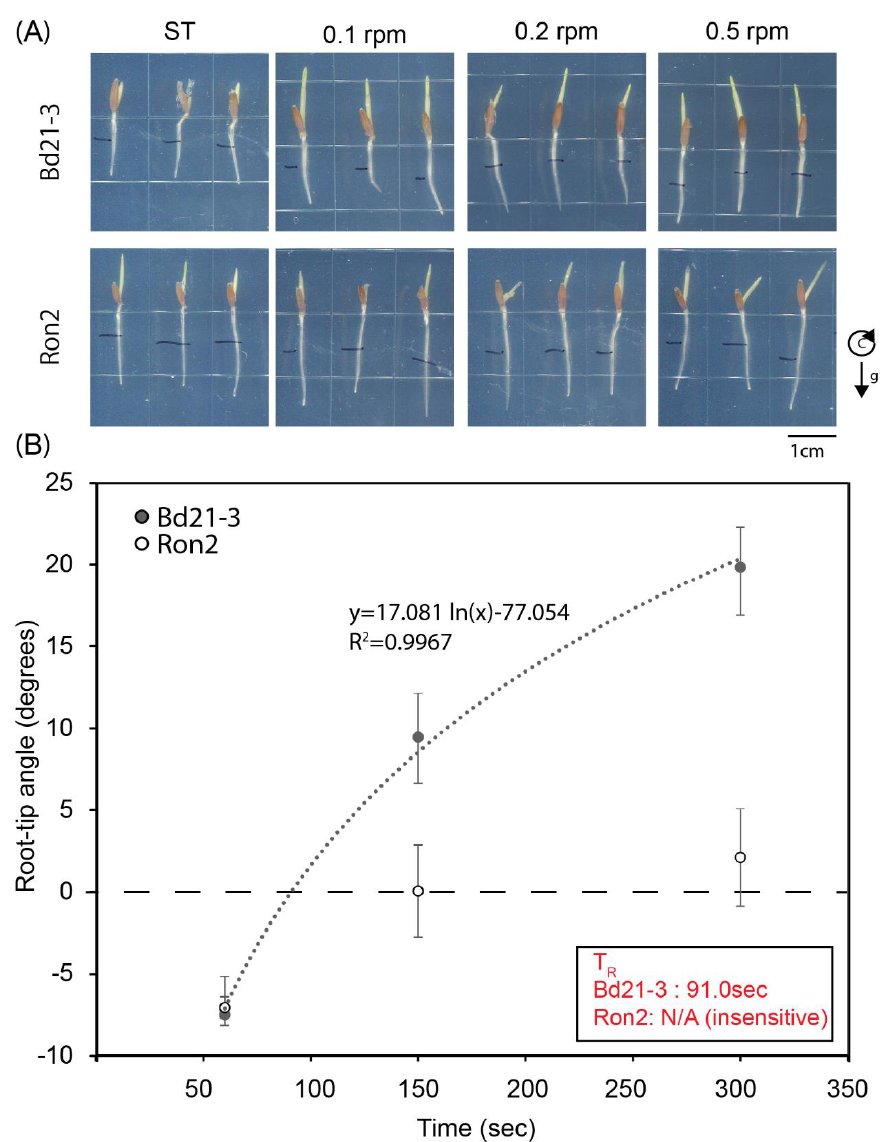
Figure 6. Brachypodium distachyon accessions display distinct root tip curvature responses to low- speed clinorotation: 3-day-old Brachypodium distachyon seedlings of the Bd21-3 and Ron-2 accessions were subjected to clinorotation at speeds of 0 (ST control), 0.1, 0.2, and 0.5 RPM for 14 h in darkness. The seedlings were photographed at the end of each experiment. Panel ( A ) shows representative root tip images of Bd21-3 and Ron-2 seedlings exposed to the clinorotation conditions summarized at the top. ( B ) Averaged root tip angles at the end of clinorotation along with their standard devia- tions are plotted over the time needed to complete half a turn of clinorotation in the corresponding experiment. A logarithmic model was fit to the data (dotted line) and used to calculate the realiza- tion time (T R ) for responding seedlings. The function associated with the best-fit model is repre- sented at the top of the graph along with the corresponding R 2 value. Ron-2 seedlings did not re- spond to clinorotation, thus it was not possible to assign a specific T R value to them. n = 6 – 11. This experiment was repeated twice, with similar results.